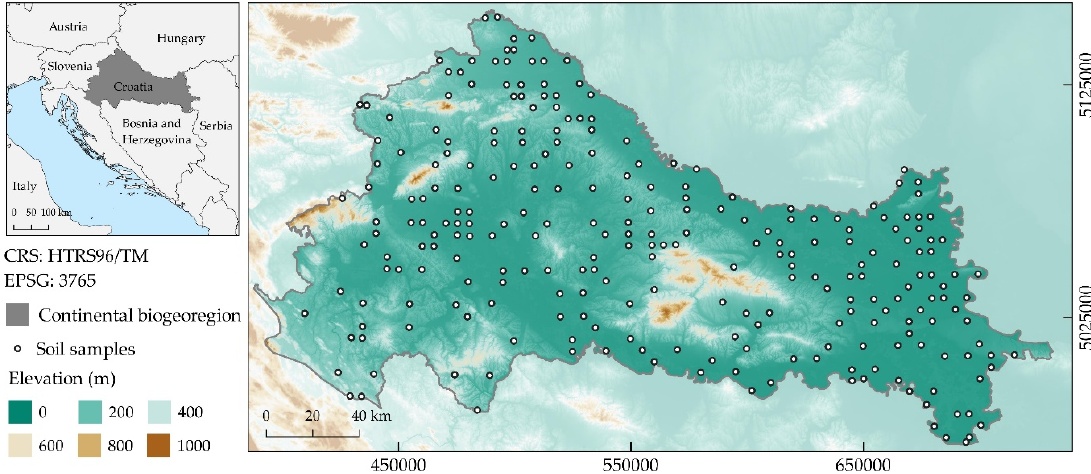
Figure 1. Continental biogeoregion of Croatia.